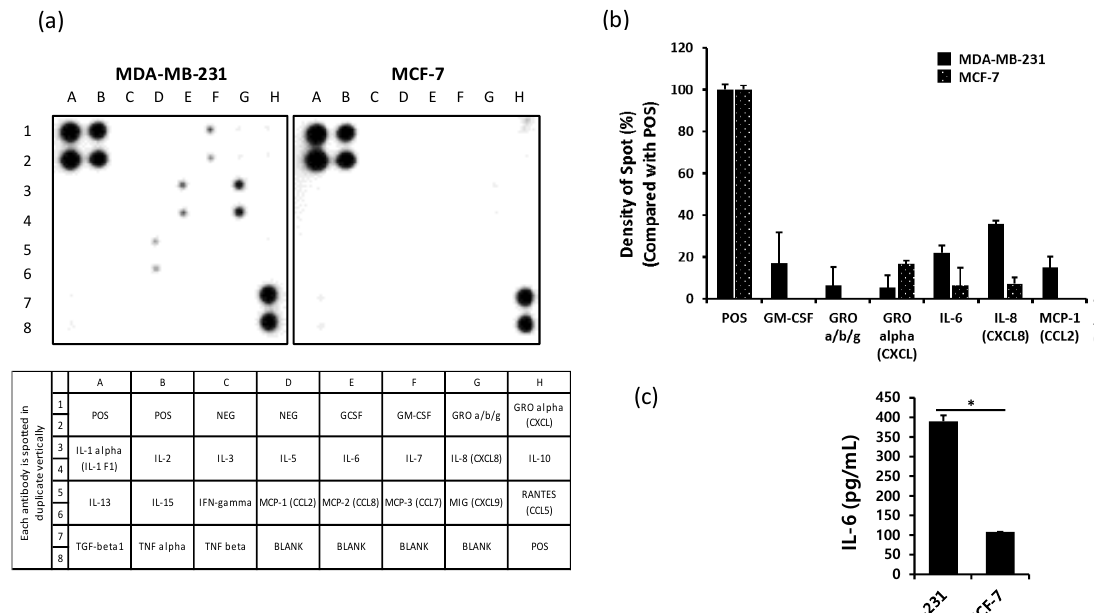
Figure 1. The production of IL-6 is higher in human breast cancer cell line MDA-MB-231 than in MCF-7. MDA-MB-231 and MCF-7 cells were seeded in six-well plates at a density of 5 × 10 5 cells / well and incubated overnight. After incubation, the supernatants were harvested for Cytokine array assay or ELISA. ( a ) Production of cytokines from MDA-MB-231 and MCF-7 cells. ( b ) Density of spots as compared with positive control (POS). ( c ) Production of IL-6 from MDA-MB-231 and MCF-7 cells. Significant di ff erence is shown: * p < 0.05. NEG, negative control; GCSF, granulocyte colony-stimulating factor; GM-CSF, granulocyte-macrophage colony-stimulating factor; GRO a / b / g, growth-regulated oncogene-a / b / g .